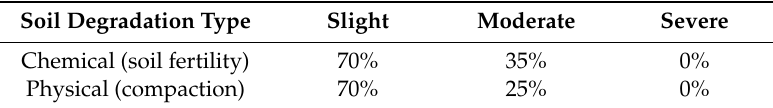
Table 12. Maximum extraction